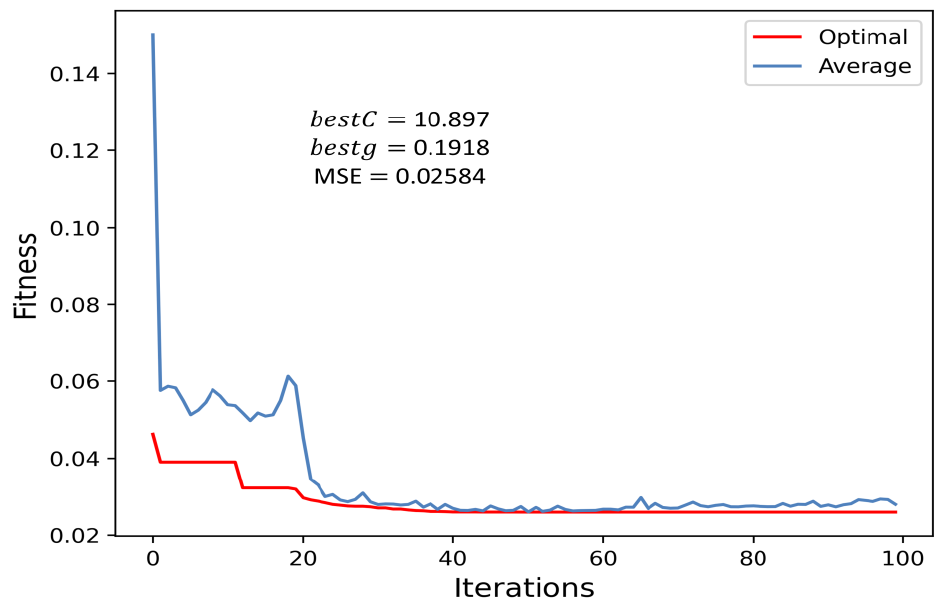
Figure 8. Fitness curves of different algorithm models.